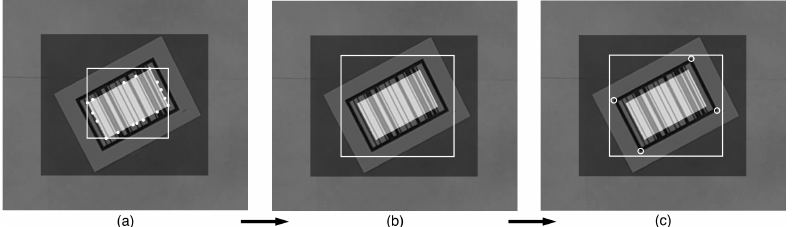
Figure 4. Bounding-box algorithms for refining localization: ( a ) finding the bounding box, ( b ) scaling the bounding box, ( c ) detecting four strong corners.